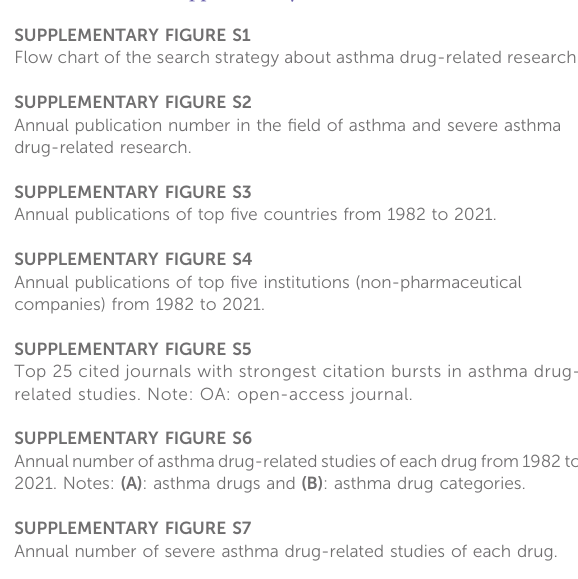
SUPPLEMENTARY FIGURE S6 Annualnumberofasthmadrug-relatedstudiesofeachdrugfrom1982to 2021. Notes: (A) : asthma drugs and (B) : asthma drug categories. SUPPLEMENTARY FIGURE S7 Annual number of severe asthma drug-related studies of each